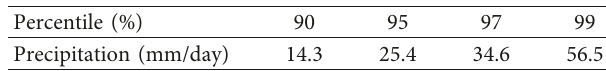
Table 1: Threshold of extreme precipitation at different terciles in the Poyang Lake